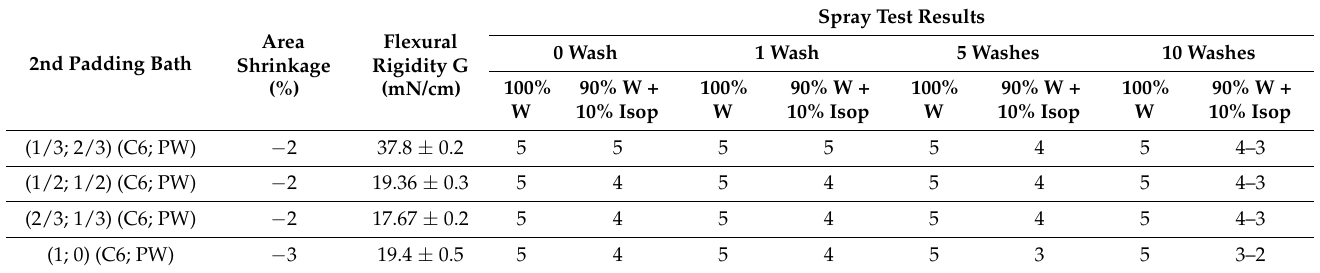
Table 7. Area shrinkage and flexural rigidity results of the samples first treated with (1/2; 1/2) (PU; PX) and then with different combinations of the second padding bath C6PW.